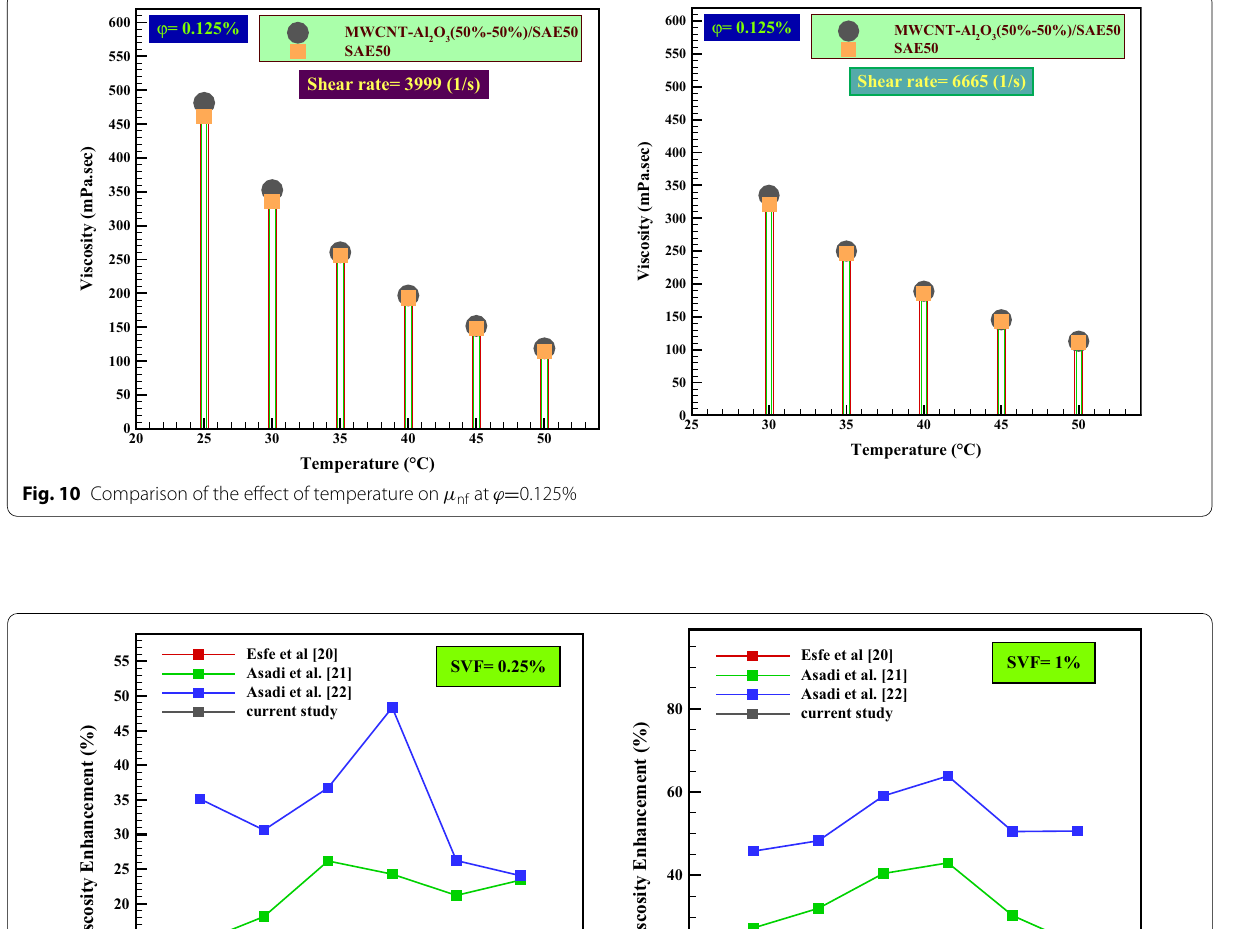
Fig. 11 Comparison of different studies with the present